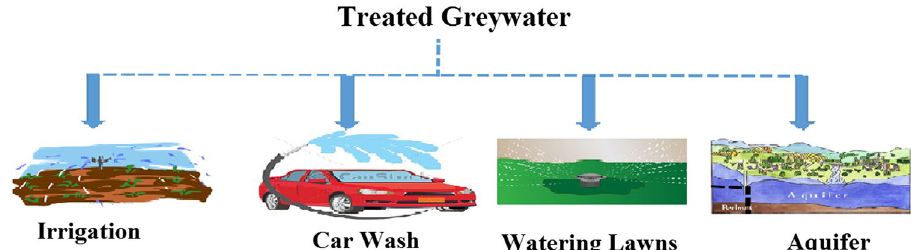
Fig. 6 Applications of treated